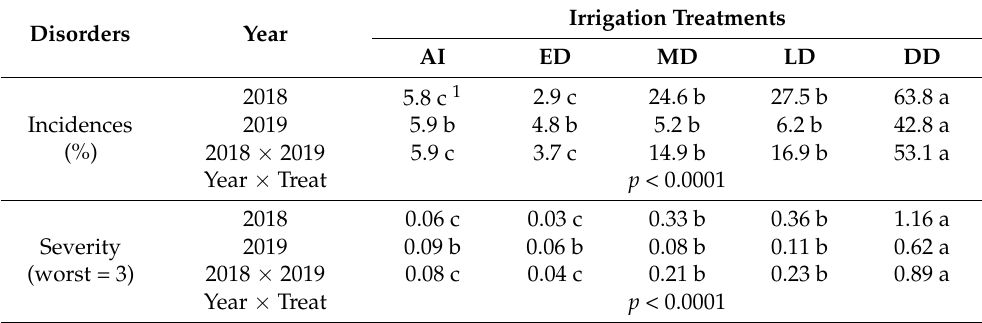
Table 5. Soft scald disorders of Ambrosia™ apples in 4 months of air storage at 0.5 ◦ C amongst samples from different irrigation treatments in the growth seasons of the years 2018 and